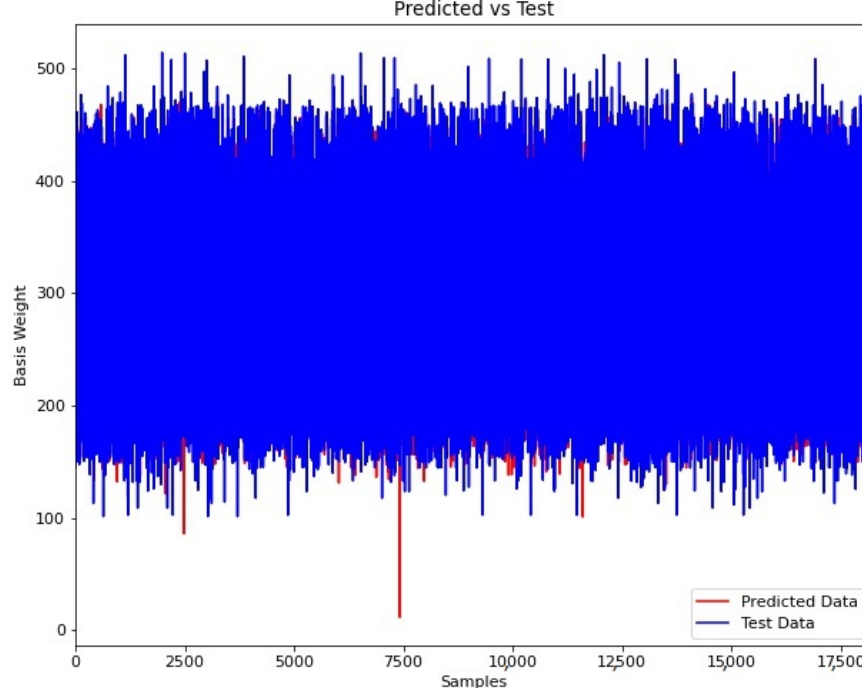
Figure 2. Training summary for the model loss level.